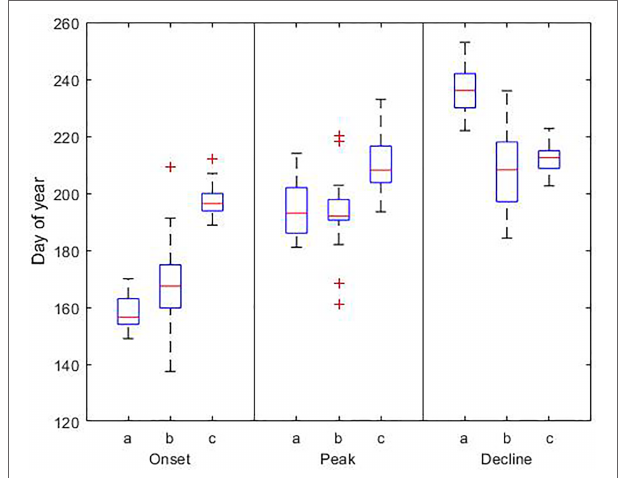
FIGURE 6 | Phenological dates for the cyanobacteria bloom based on a) model results (1990-2019), b) observations (1990-2017), and c) satellite data (1998-2015). In each box, the central red line indicates the median, and the bottom and top edges of the box indicate the 25th and 75th percentiles, respectively. The whiskers extend to the most extreme data points; outlier observations are marked individually using the ‘+’. Details of the data sets used are reported in Table 3 .